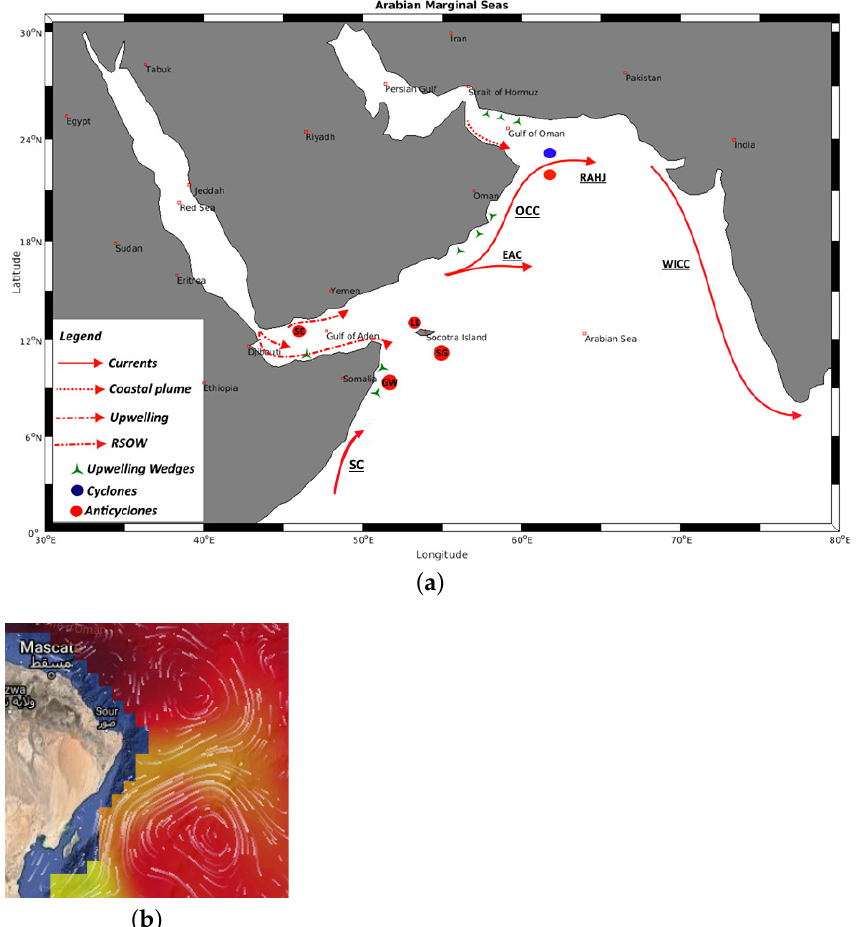
Figure 1. ( a ) Regional map of the Arabian Sea—in summer—displaying the main oceanographic phenomena: Currents, outflows, upwellings, and eddies and ( b ) snapshot of the Ras al Hadd dipole in summer 2020 with the cyclone to the northeast and the anticyclone to the southwest (from “Ocean Virtual laboratory web portal (ESA, OceanDataLab, https://ovl.oceandatalab.com (accessed on 1 December